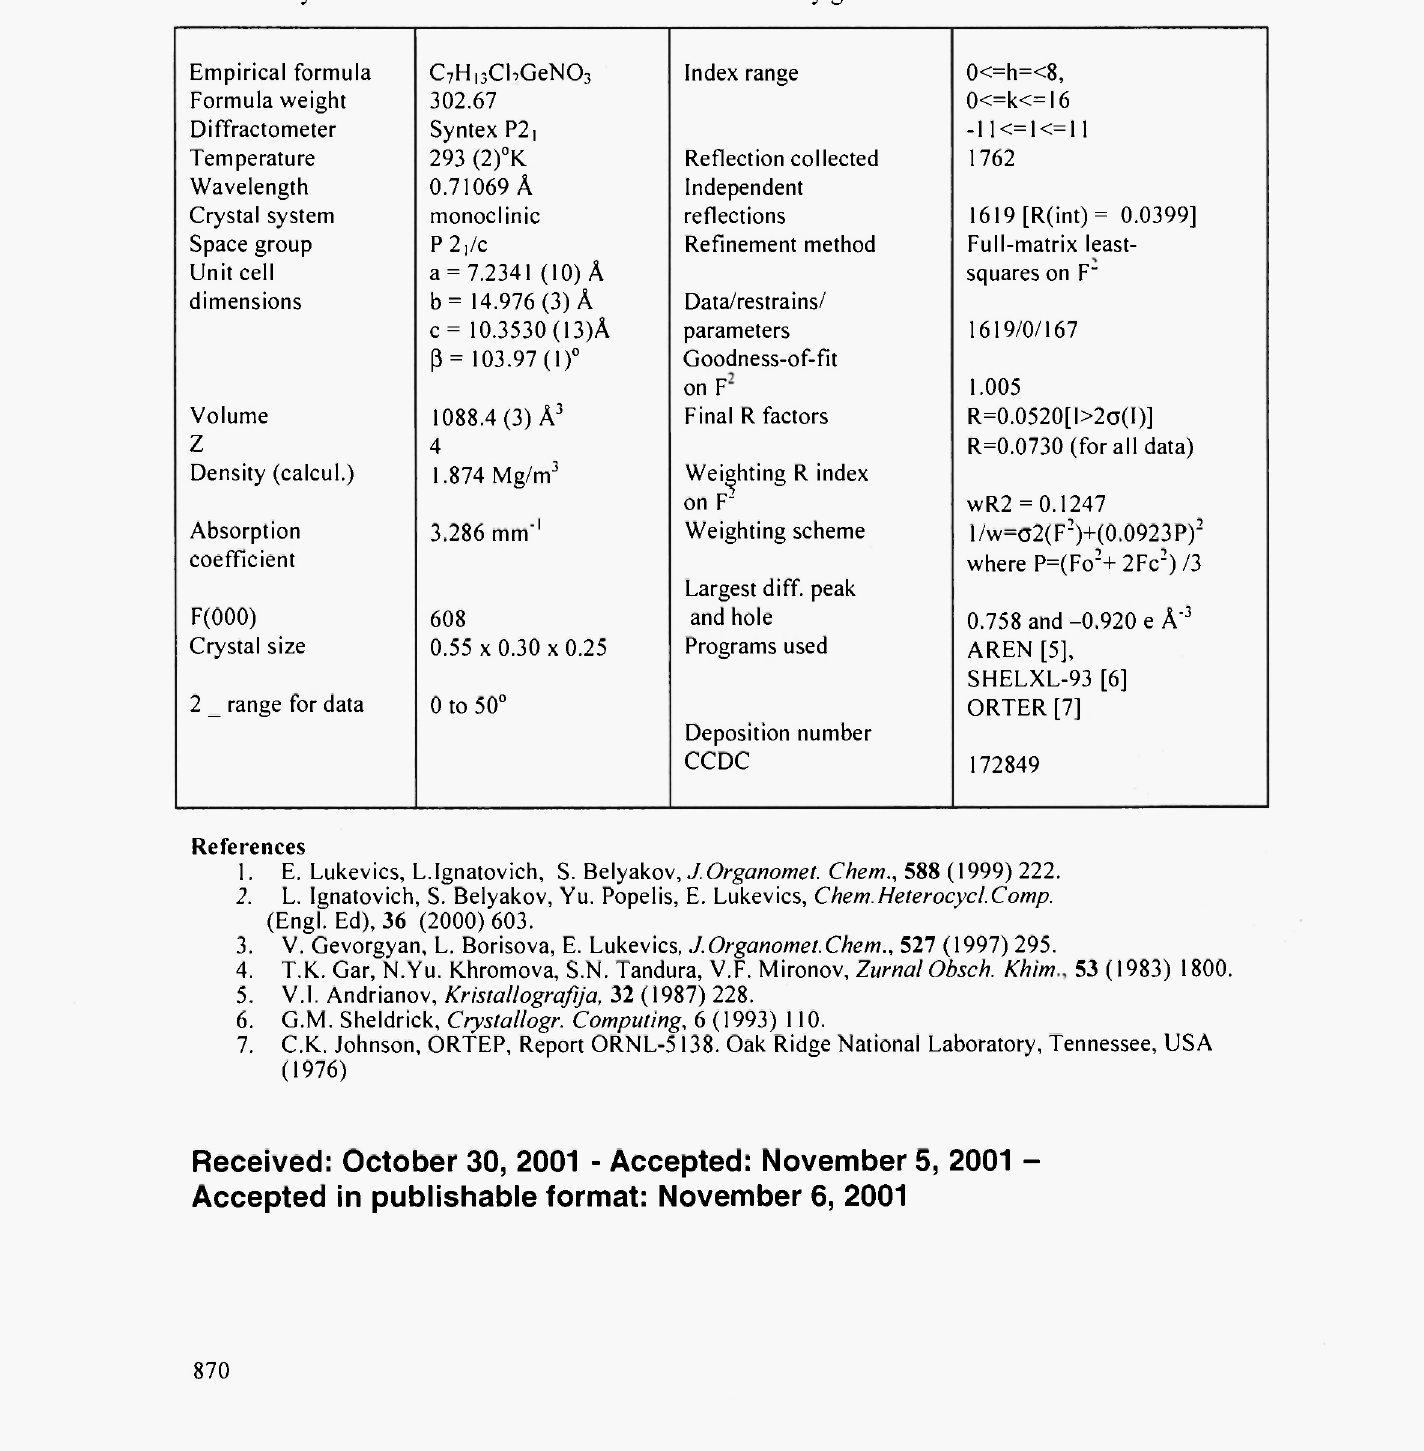
Table 1. Crystal data and structure refinement for